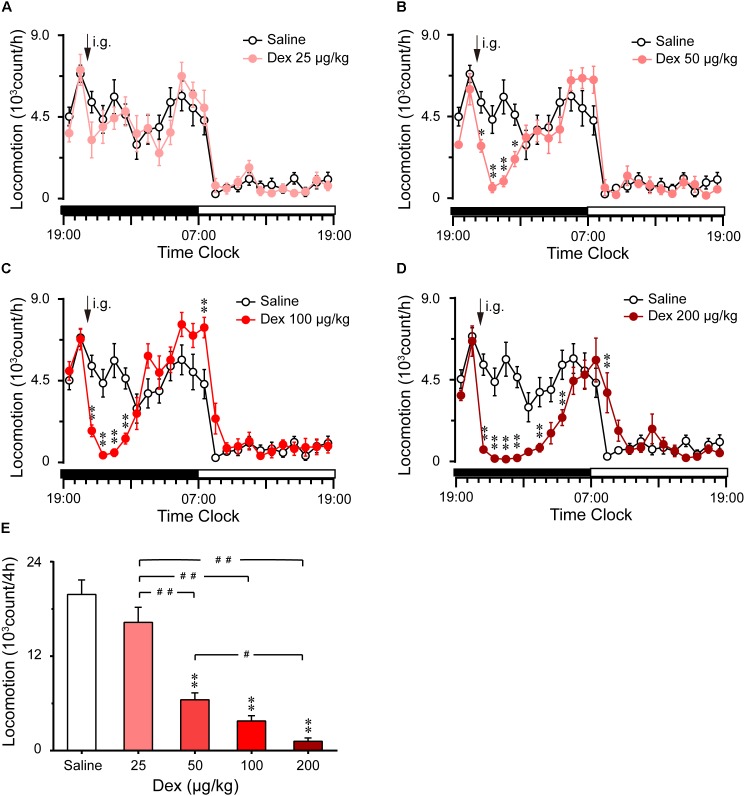
Effects of oral delivery dexmedetomidine on LMA in mice during the dark phase. (A–D) Time course changes in LMA following saline (open circle) or dexmedetomidine (25, 50, 100, and 200 μg/kg, i.g.; closed red circle) administration during the dark phase. Each circle represents the hourly mean amount of LMA. The horizontal filled and open bars on the X-axes indicate the 12-h dark and 12-h light periods, respectively. Values are means ± SEM (n = 8), ∗P < 0.05 and∗∗P < 0.01 indicate significant differences compared with the saline control as assessed by two-way repeated measures ANOVA followed by Bonferroni testing. (E) Total counts of LMA during the 4-h period following saline or dexmedetomidine (25, 50, 100, and 200 μg/kg, i.g.). Values are means ± SEM (n = 8). ∗∗P < 0.01 indicates a significant difference compared with the control group, ##P < 0.01 indicates a significant difference between the different doses of dexmedetomidine as assessed by one-way ANOVA followed by Bonferroni tests.